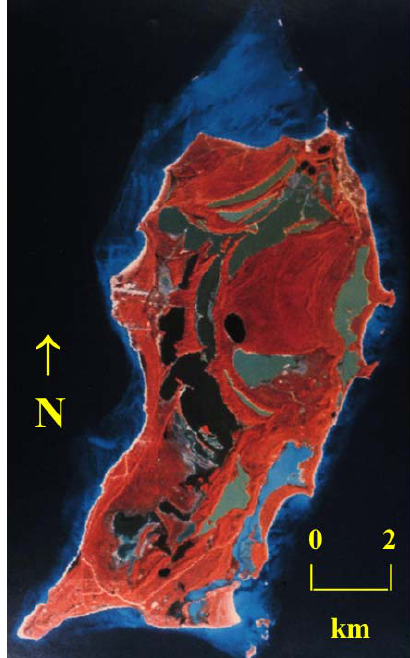
Figure 8. Satellite false-color image of San Salvador Island, Bahamas, courtesy of NASA. The image displays the problems of assuming the freshwater lens size is equivalent to island size. The light blue water body on the southeast side of the island is Pigeon Creek, a sea water lagoon. Dark bodies of water are inland lakes with normal or slightly elevated marine salinities. The light gray/green water bodies are hypersaline lakes (commonly 80 ppt). The freshwater lens exists as multiple lenses that are found only in the land masses that separate the inland water bodies. Also note that the island occupies about 80% of the small platform it rests on (light blue rim around the island, largest to the north). A sea-level drop will increase island size by only a small amount, but will eliminate the interior lakes, which are all